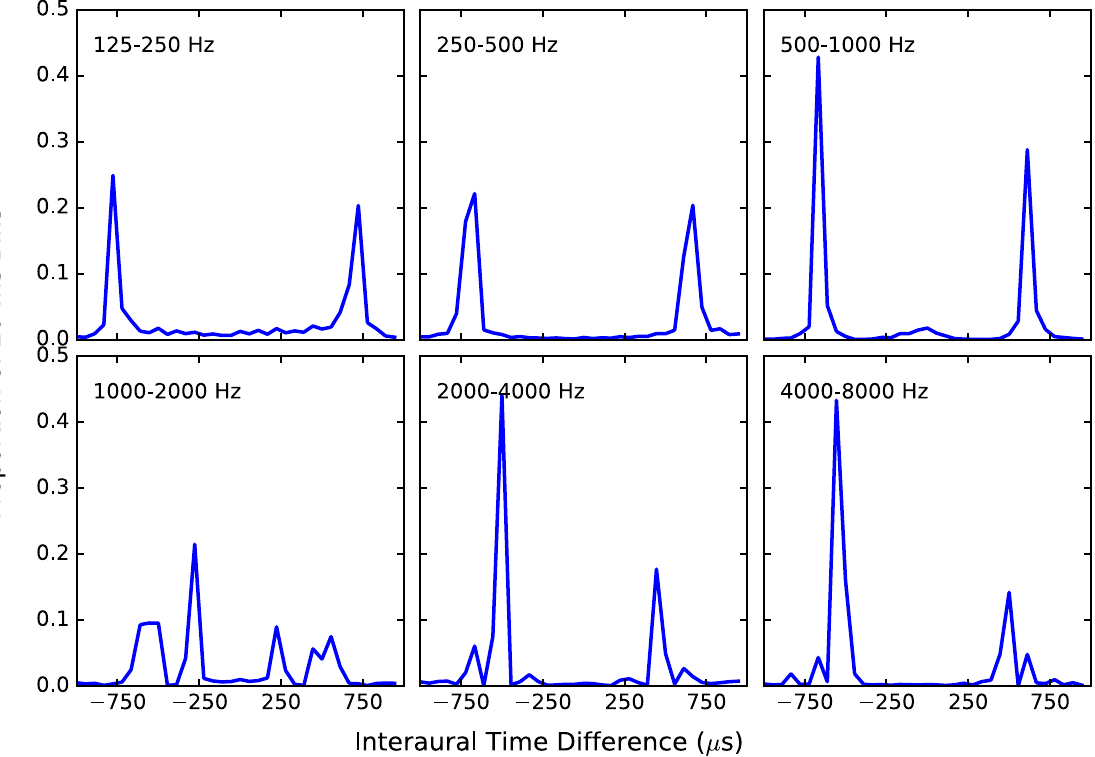
Fig 8. ITD frequency histograms for various frequencies. Acoustic analysis was conducted on 50 pairs of sentences (about 2.5 minutes of data) produced by different female talkers, in which head-related impulse responses were applied to each such that one was 60 degrees to the left, and the other 60 degrees to the right. The sentences were then combined, filtered into six one-octave wide frequency bands, and an ITD was then estimated every 20 ms in each band. Each plot represents the proportion of occurrence of a given ITD among the time bins. Each panel shows acoustic analysis data for a particular frequency